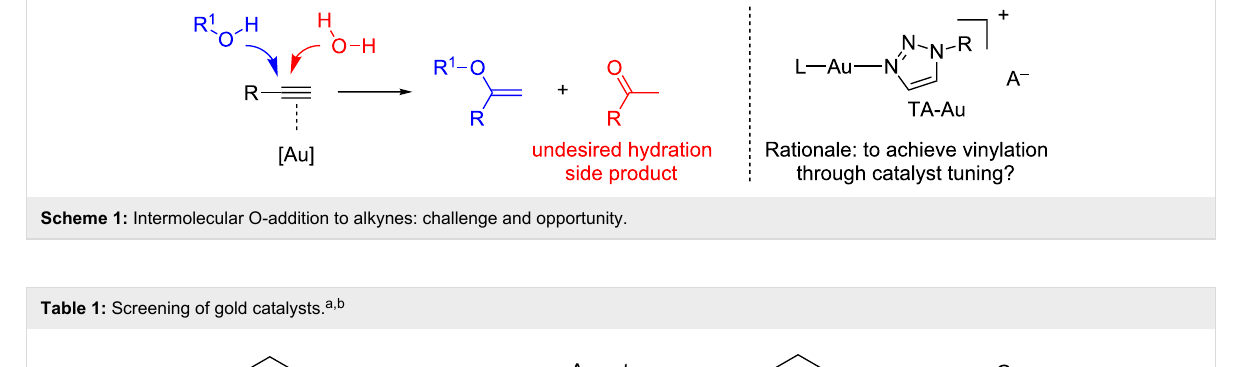
Table 1: Screening of gold catalysts. a,b